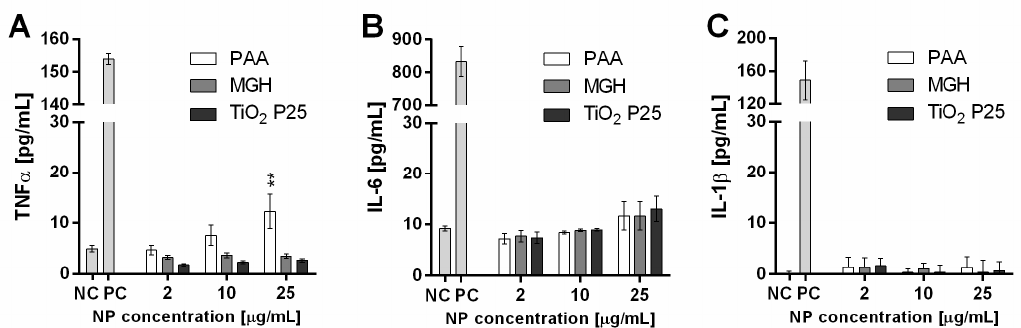
Figure 4. Secretion of ( A ) TNF α , ( B ) IL-6 and ( C ) IL-1 β cytokines following incubation with increasing concentration of biomedical polyacrylic acid (PAA) coated cobalt ferrite NPs, industrial TiO 2 P25 NPs and uncoated maghemite (MGH) NPs in mouse microglial cells as determined with ELISA. For TNF α and IL-6, 100 ng / mL LPS was used as a positive control (PC). For IL-1 β , cells were primed with 100 ng / mL LPS for 6 h before exposure and 200 µ g / mL crystalline SiO 2 NPs were used as PC. Mean and standard error are shown for three independent experiments performed in three technical repeats. Statistical significance is displayed as: ns ( p > 0.05); ** p ≤ 0.01.